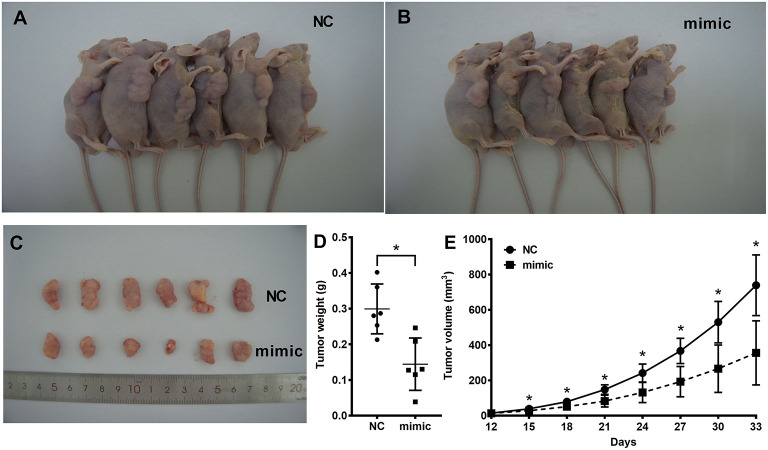
The miR-935 mimics inhibit the growth of human glioma in the xenograft tumor model. (A,B) Images of xenograft tumor implanted nude mice 5 weeks after cell injection. (C) Images of tumors after 5 weeks of implantation at the time of measurement. (D) Tumor weight was measured. (E) Tumor volume was significantly increased after 5 weeks of implantation in the miR-935 mimic group compared to the miR-NC group. The data are shown as the mean ± SD.; *p < 0.05 between the indicated groups or at the indicated time points.